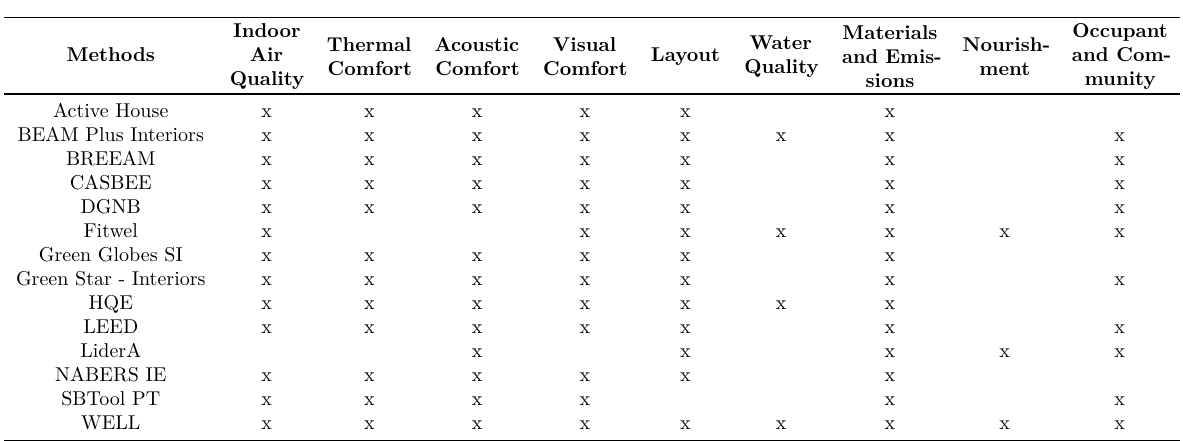
Table 2. Categories presented by the studied